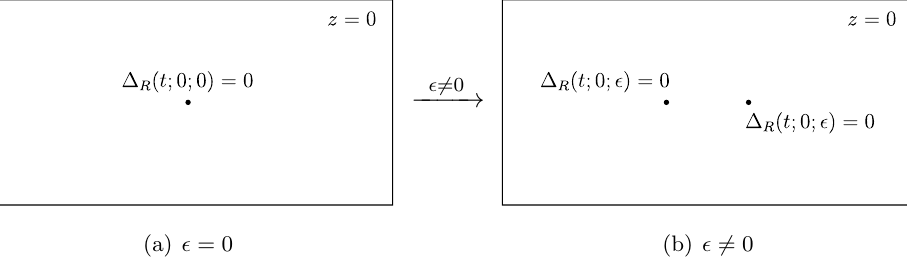
Figure 2 . Splitting of the I 1 locus associated with the deformation to (cid:15) 6 = 0 that transitions the simply-laced gauge algebra to the non-simply-laced